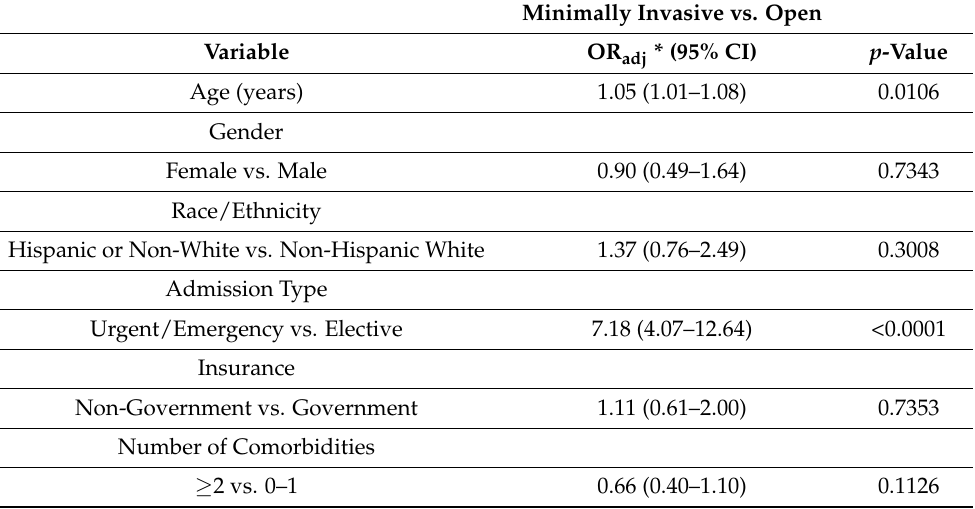
Table 5. Independent Factors Associated with Receipt of Minimally Invasive vs. Open Surgery ( n =